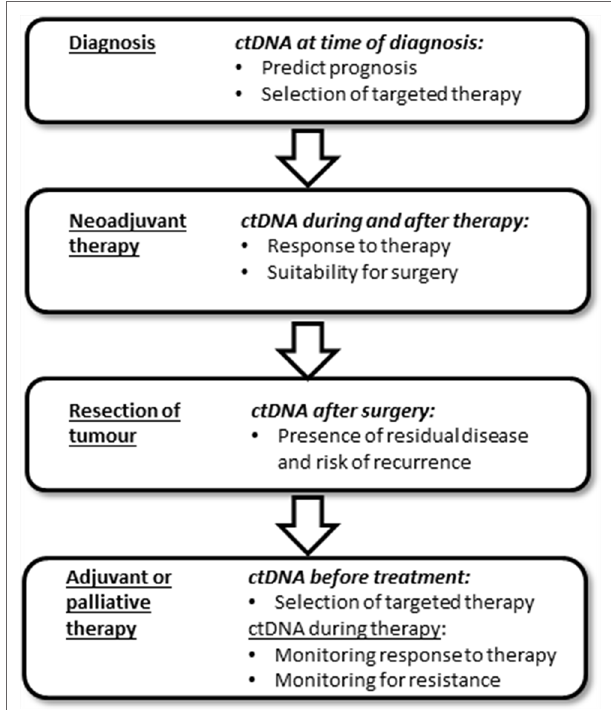
FiGURe 1 | Flow diagram of studies included in the review. 1 Total of surgery and systemic therapy studies are greater than 92 as some studies analysed both types of treatment.